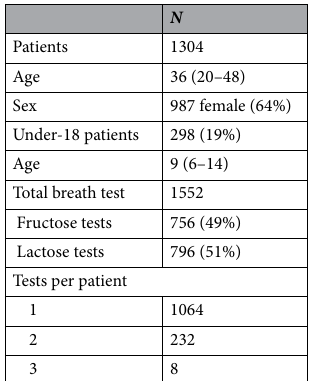
Table 4. Demographic characteristics of patients included in the study. Age is indicated as median and interquartile range (Q1–Q3) is shown in a